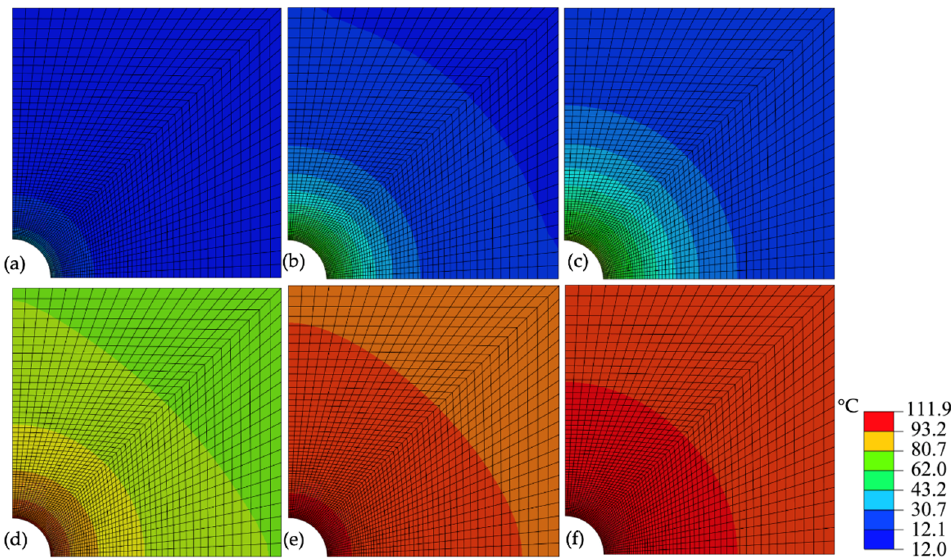
Figure 11. Temperature profile contour for soil at the end of ( a ) the 1st loading cycle; ( b ) the 13th loading cycle; ( c ) the 25th loading cycle; ( d ) the 400th loading cycle; ( e ) the 800th loading cycle; and ( f ) the 1000th loading cycle.